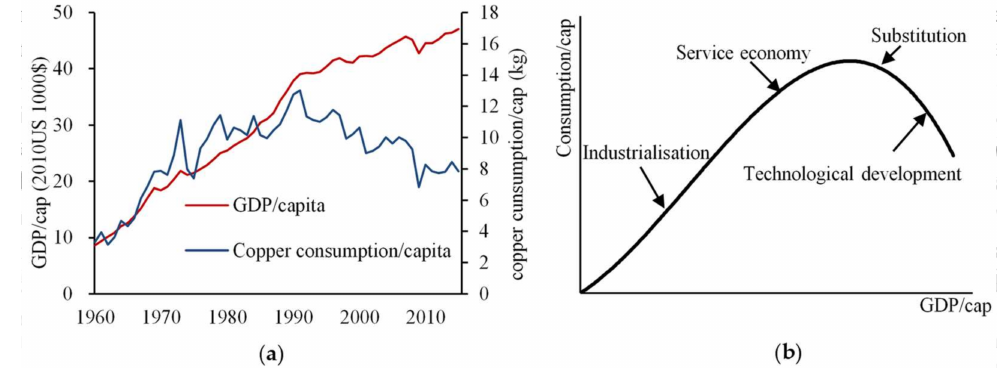
Figure 7. ( a ) The relationship between copper consumption per capita and GDP per capita in Japan (Data: various References [71–73]); ( b ) Conceptual diagram of